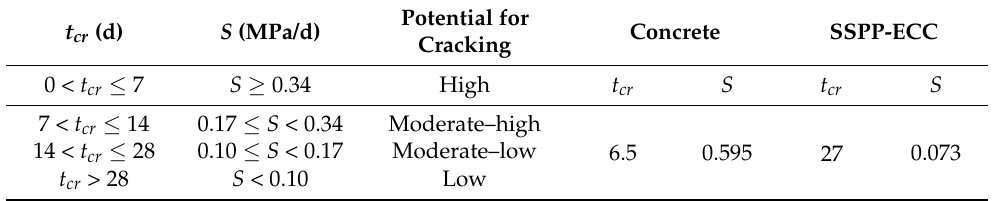
Table 4. Potential for cracking classification.